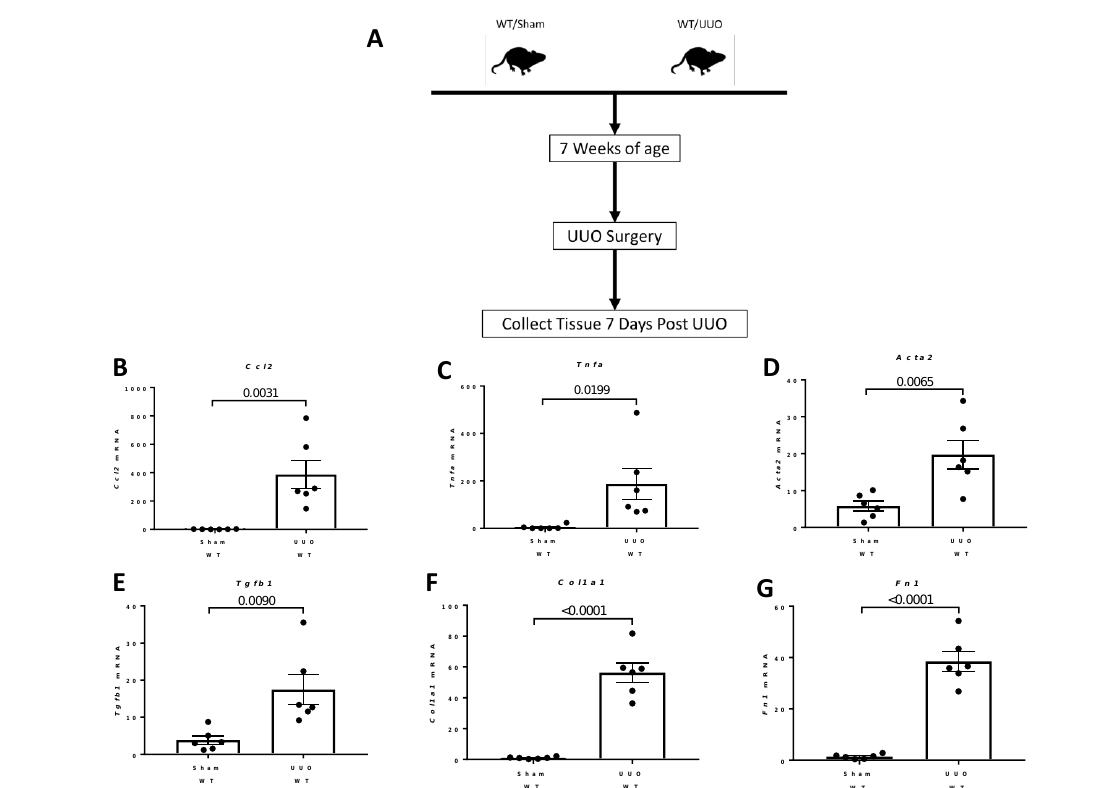
Figure 17. Unilateral ureteral obstruction (UUO) and Fstl1 expression. ( A ) Schematic diagram summarizing experimental workflow and collection of tissue from 7 week old C57B6 mice subjected to sham ( n = 4) or UUO ( n = 5) surgery. 7 days after surgery, mice were sacrificed, and kidney tissue was collected for analysis of mRNA levels. ( B , C ) Graphical representation of mRNA levels for selected genes implicated in kidney inflammation ( Ccl2 , Tnfa ) in 7 week old wild type sham versus 7 week old UUO mice. Values are mean ± SEM (black bars). P values were determined by Student’s t tests, and significance was defined as a p value <0.05. ( D – G ) Graphical representation of mRNA levels for selected genes implicated in kidney fibrosis ( Acta2 , Tgfb1 , Col1a1 , Fn1 ) in 7 week old wild type sham versus 7 week old UUO mice. Values are mean ± SEM (black bars). P values were determined by Student’s t tests, and significance was a p value < 0.05.